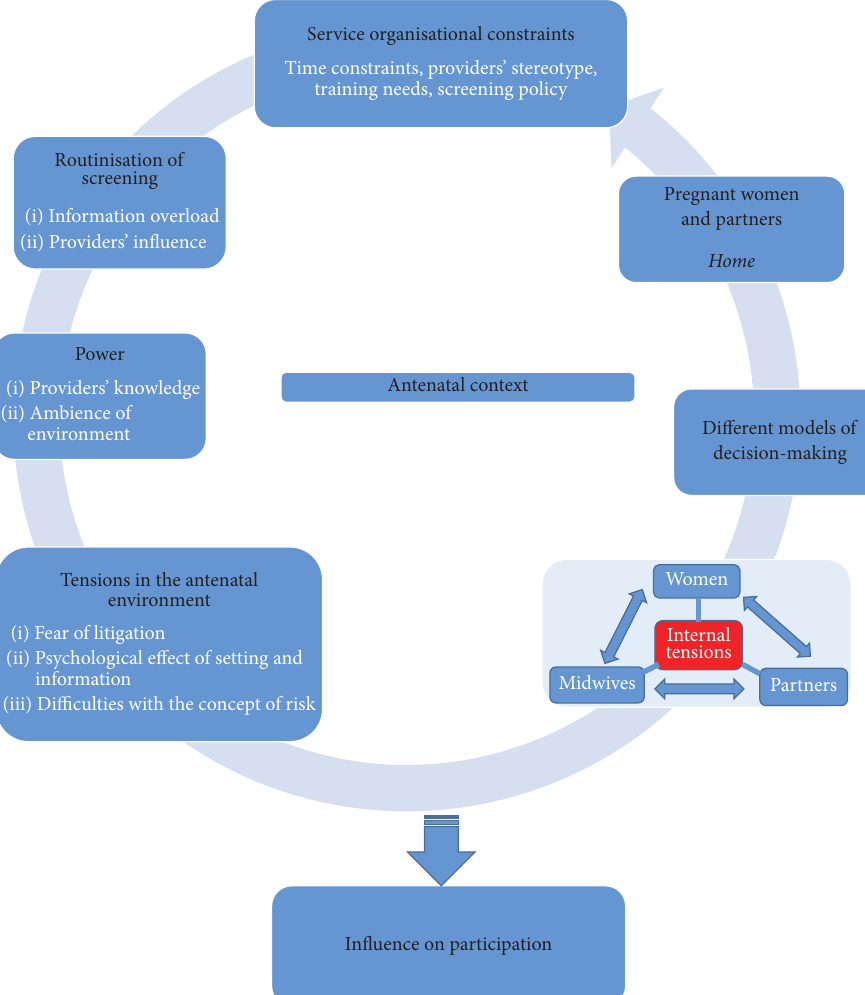
Figure 2: A conceptual framework showing participants’ perceptions of the influence of service delivery on participation in antenatal Down’s syndrome